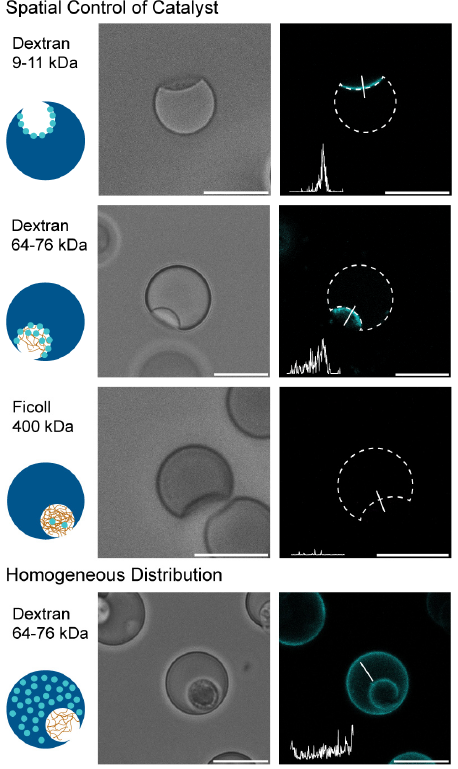
Figure 2. Confocal microscopy images of the different micromotor systems. Catalase was labelled with a fluorescent dye, Alexa 647, to analyse its position inside the motor. Bright field images are shown left, and the corresponding fluorescence images are on the right. The position of the motor is shown in dashed lines and the fluorescence intensity profile (bottom left) was obtained over the solid line going from the opening inside the motor. Spatial control over the catalyst was obtained by dissolving the enzyme in the polysaccharide phase prior to injection into the chip. As a control the catalyst was dissolved in the PEGDA gel phase, and a homogeneous distribution throughout the bead was observed. Scale bar is 20 µ